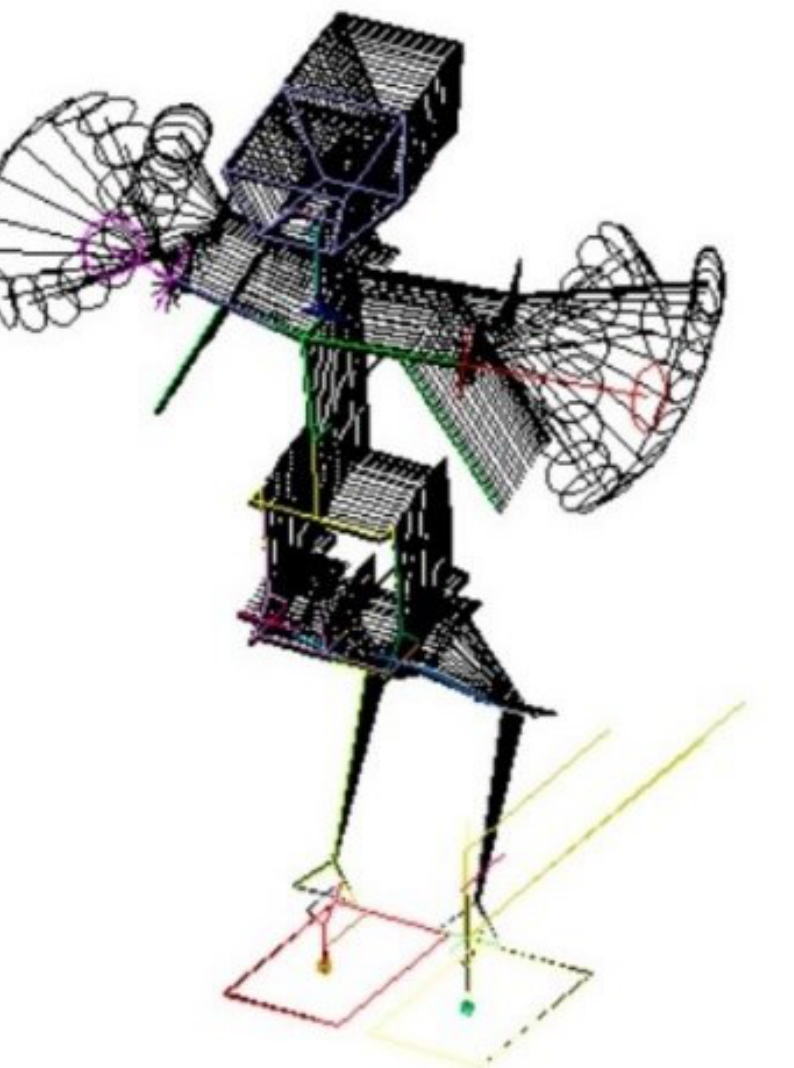
Figure 4. The movement picture of the android’s movement when the center of mass is shifted backward while maintaining the magnitude of the reaction torque in the support relative to the transverse